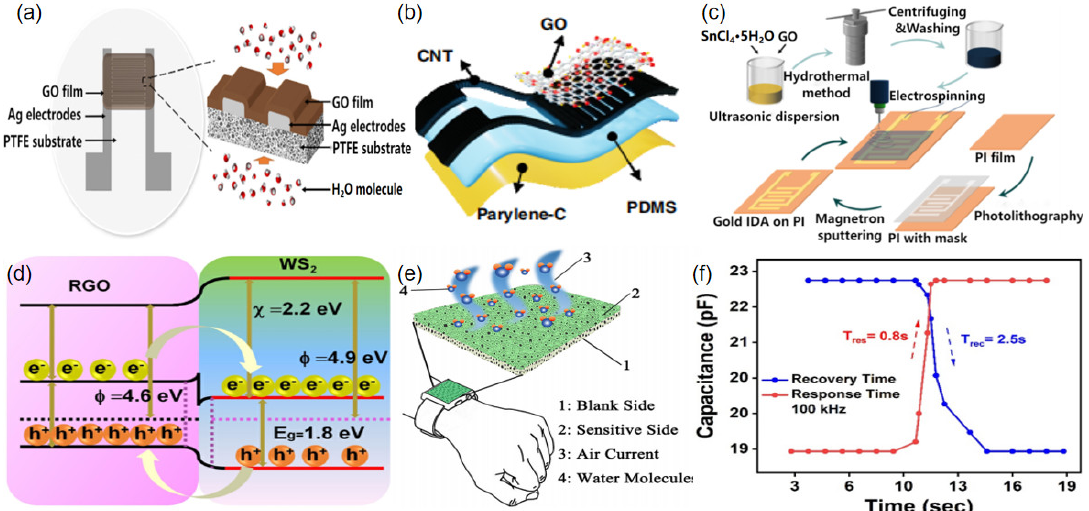
Figure 2. ( a ) Structure of a flexible humidity sensor using graphene oxide and PTFE (reproduced with permission from [47]); ( b ) exploded view of a CNT-based flexible sensor (reproduced with permission from [49]); ( c ) illustration of the process of preparing a SnO 2 /RGO humidity sensor (reproduced with permission from [50]); ( d ) illustration of the different mechanisms of interaction between RGO and WS 2 (reproduced with permission from [53]); ( e ) illustration of a PANI/PVDF IFHS sensor (reproduced with permission from [55]); ( f ) response and recovery time of a capacitive humidity sensor at 10 kHz (reproduced with permission from [56]).